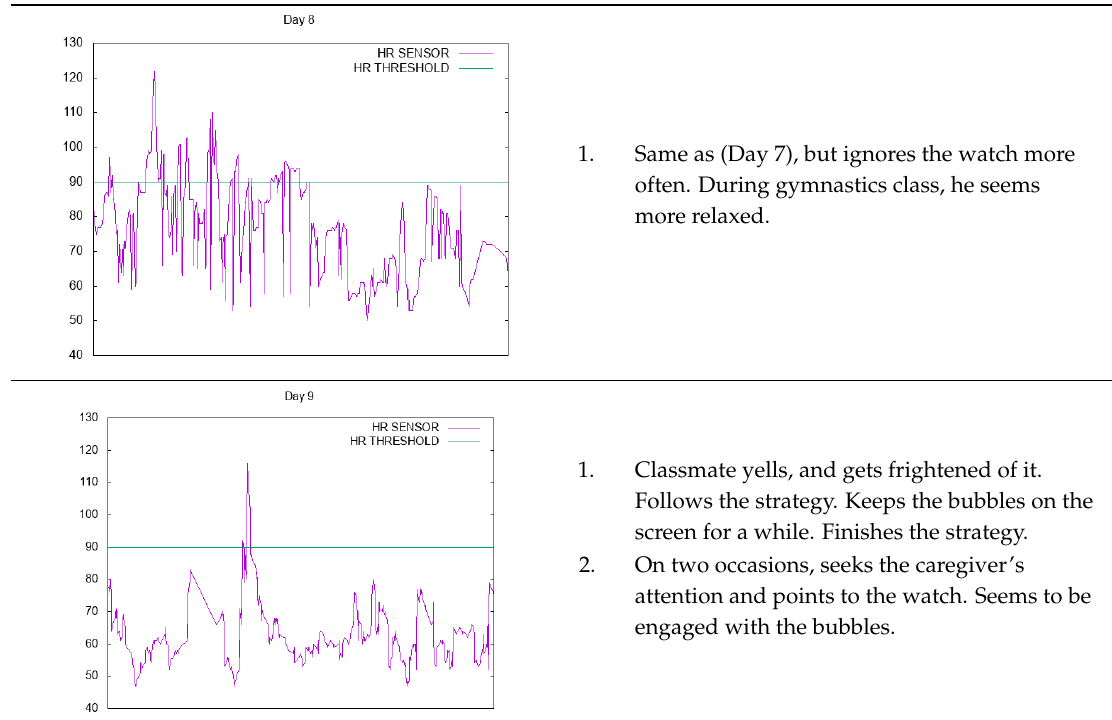
1. Same as (Day 7), but ignores the watch more often. During gymnastics class, he seems more relaxed.